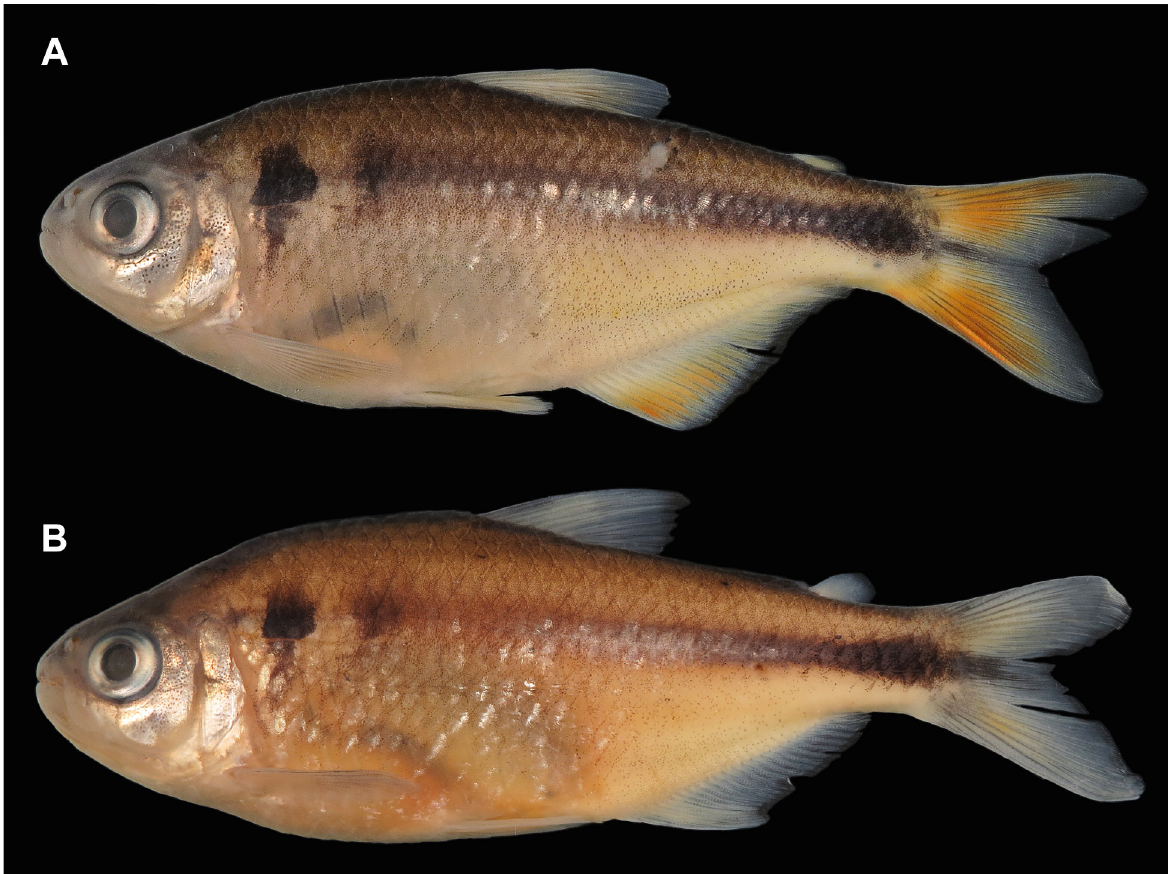
Figure 2. Astyanax bifasciatus . A. UFRGS 26235, 85.0 mm SL, Arquimedes stream, lower Iguaçu river basin, Paraná, Brazil. B. UFRGS 26231,